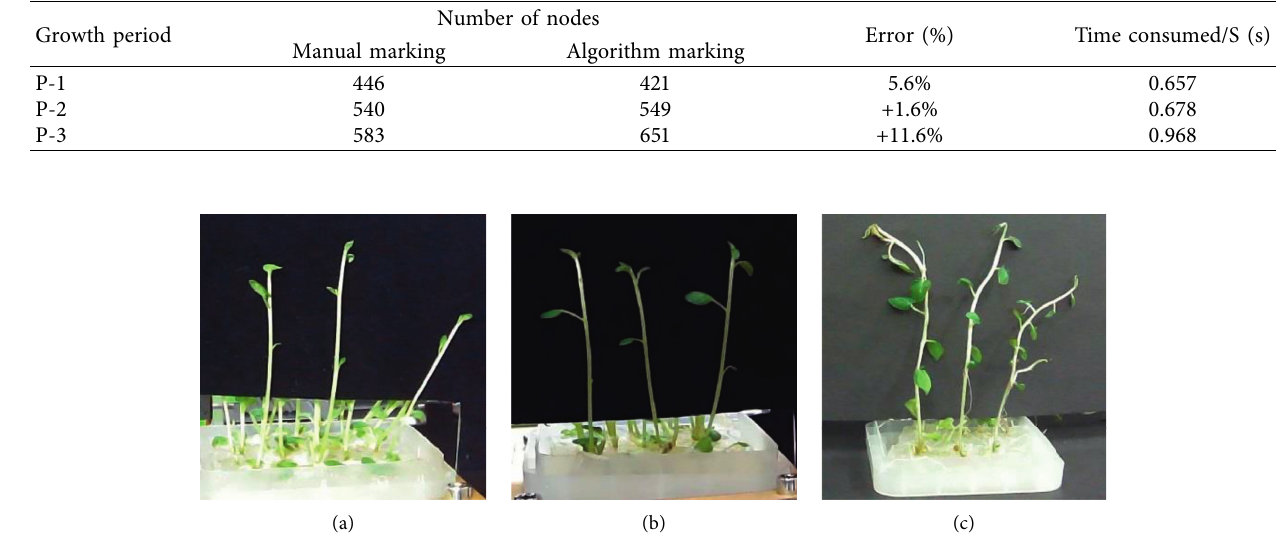
Figure 8: Different growth periods. (a) P-1. (b) P-2. (c) P-3.